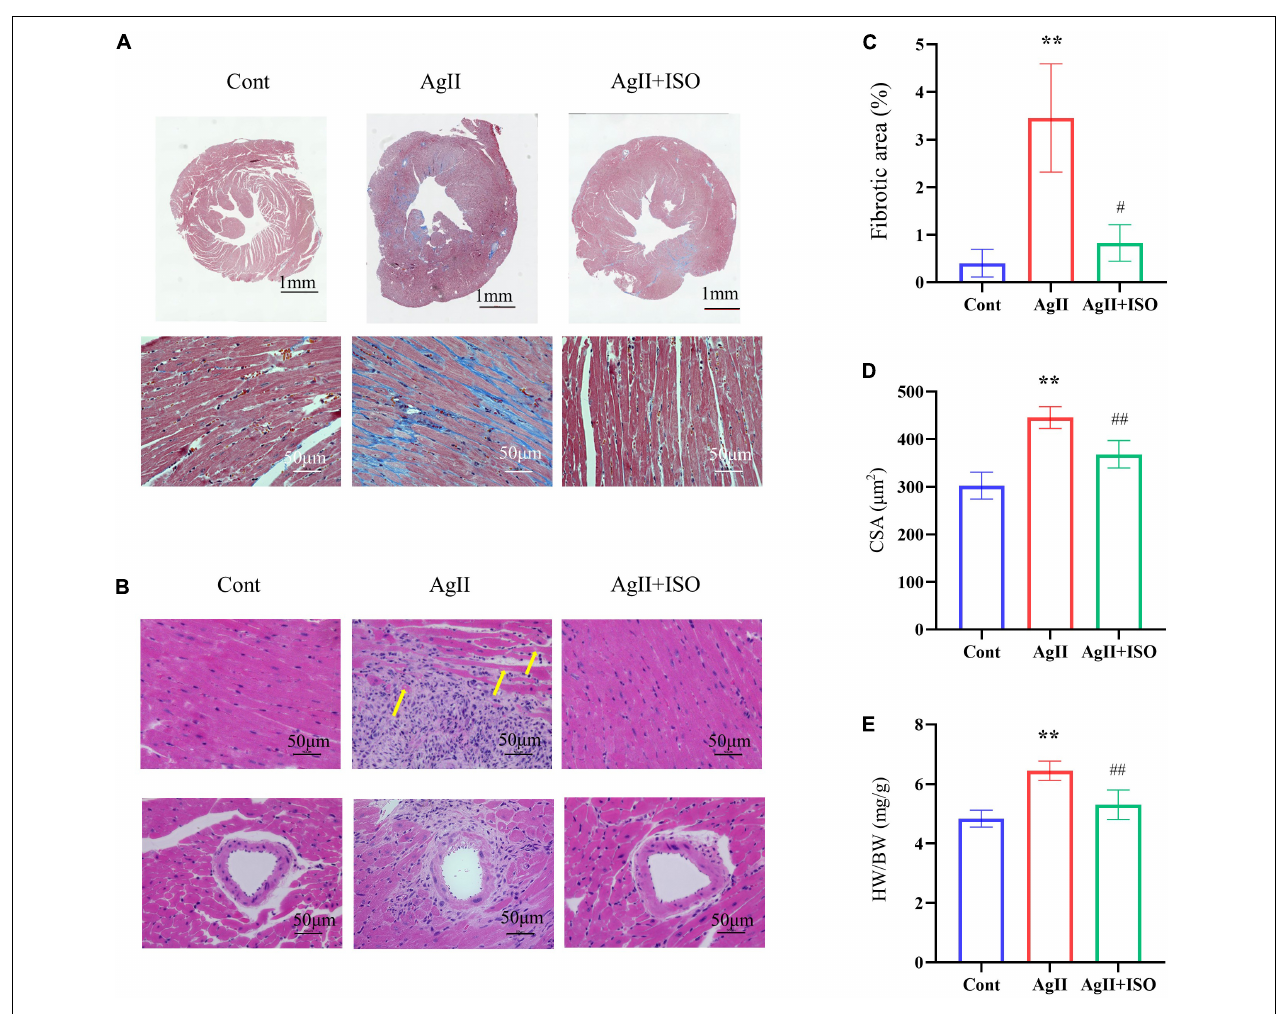
FIGURE 3 | Histological analyses of MT staining (A) and H-E staining (B) of each group of mice at 11 weeks. The yellow arrows indicate cytoplasmic vacuolization of cardiomyocytes. (C) The fibrotic area to the total area ( n = 3 per group). (D) The results of the quantitative analysis of the cross-sectional area (CSA). (E) The statistical results of HW/BW ( n = 7 per group). * P < 0.05, ** P < 0.01 vs. Cont. # P < 0.05, ## P < 0.01 vs. AgII +